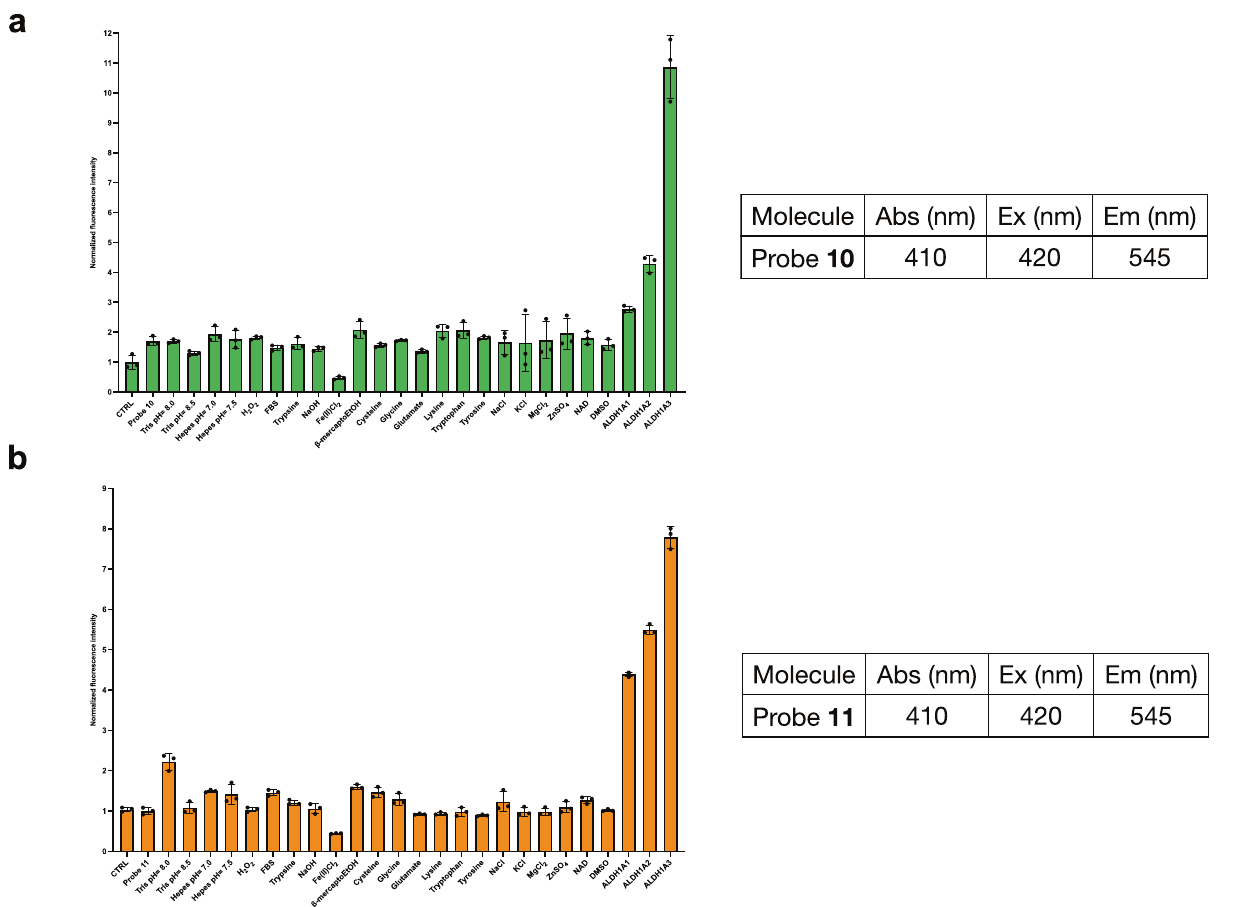
Fig. 2 Biochemical characterization of the interaction of probe 10 with human ALDH1A3. a Increase of Probe 10 fl uorescence intensity in presence of various biomolecules reactive at concentrations of 100 μ M. For all assays, Probe 10 was used at 10 μ M fi nal concentration and valuation of the absorbance, excitation and emission wavelengths of the compound Probe 10 at a fi xed concentration of 10 µ M in the SEC buffer. b Increase of Probe 11 fl uorescence intensity in presence of various biomolecules reactive at concentrations of 100 μ M and evaluation of the absorbance, excitation, and emission wavelengths of the compound Probe 11 at a fi xed concentration of 10 µ M in the SEC